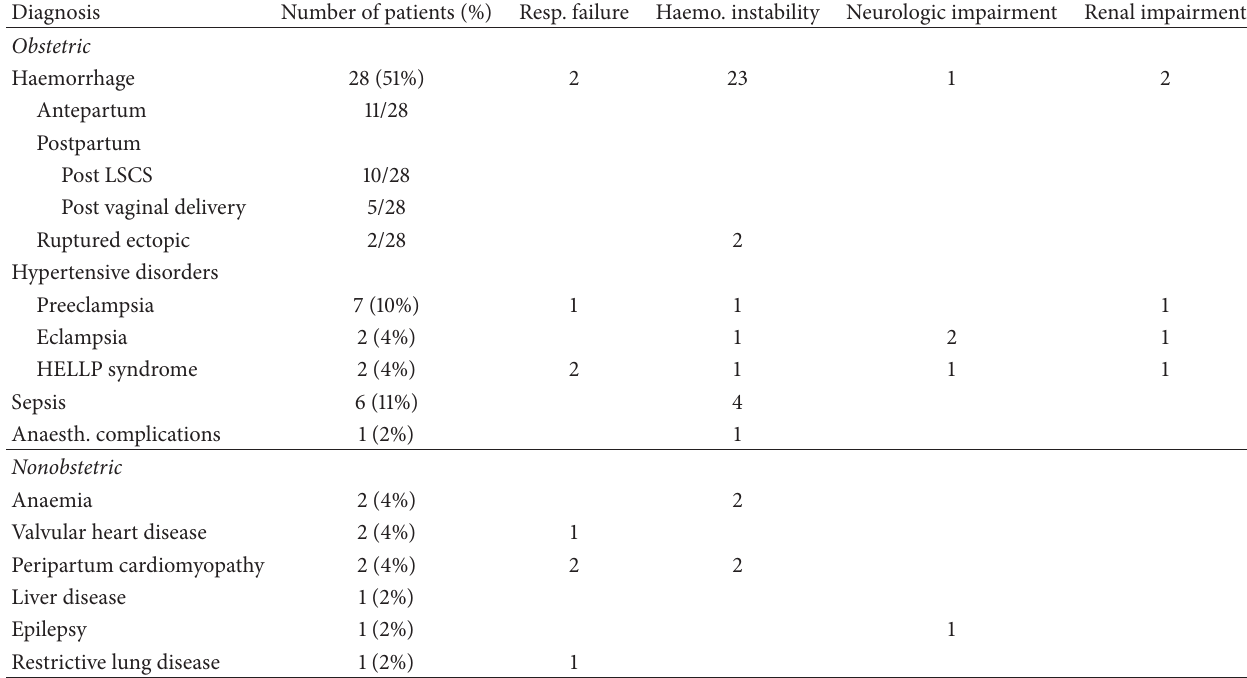
Table 3: Admission diagnosis.